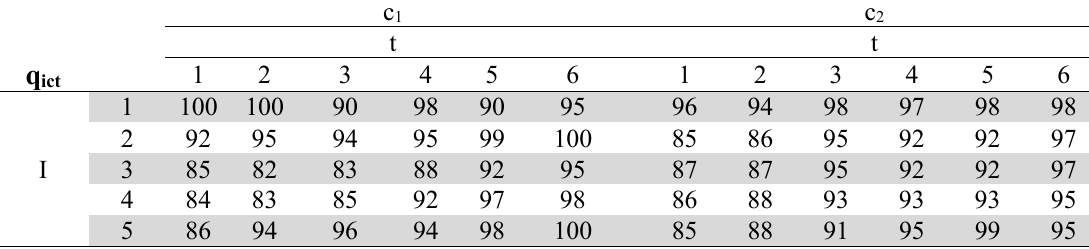
Quality of projects